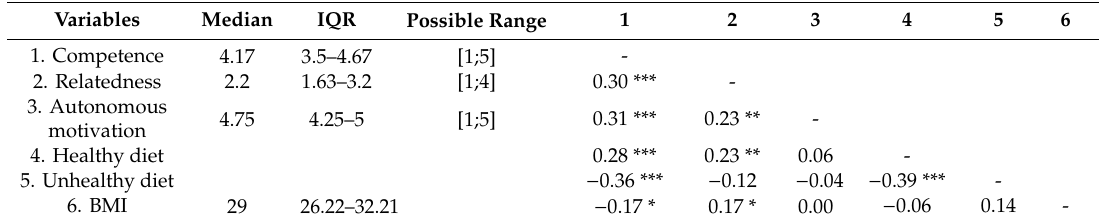
Table A2. Spearman correlation coe ffi cients between SDT variables, dietary patterns and body mass index